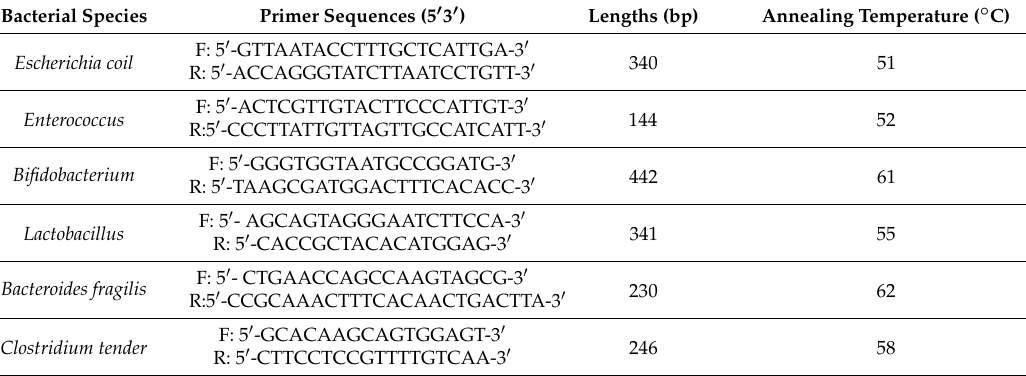
Table 2. Primer sequences and annealing temperature of PCR amplification of specific bacterial.